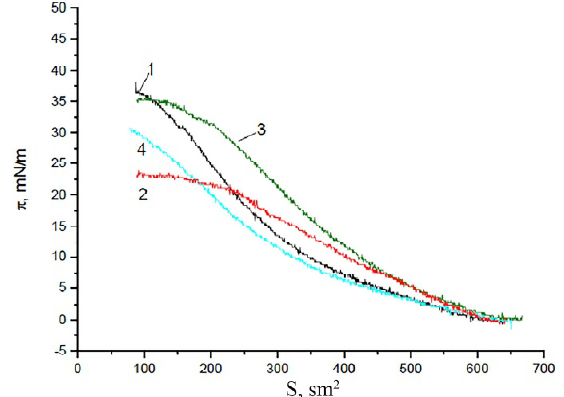
Fig. 2.  -A isotherms of nanoparticles on water 1 - nickel HCF, 2- copper HCF, 3 - cobalt HCF, 4 - iron HCF, modified with CTAB.